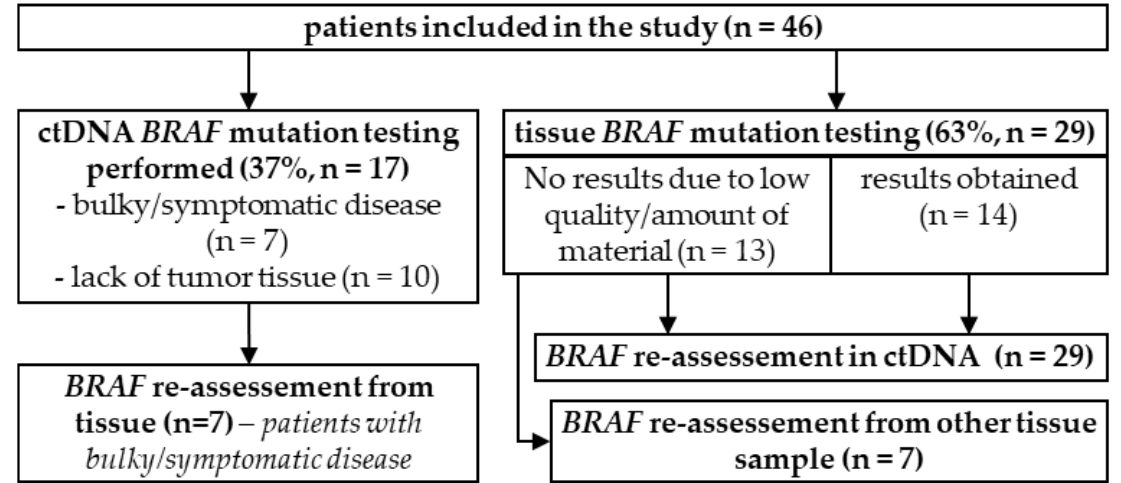
Figure 1. Flowchart of different BRAF mutation testing methods in the study population.